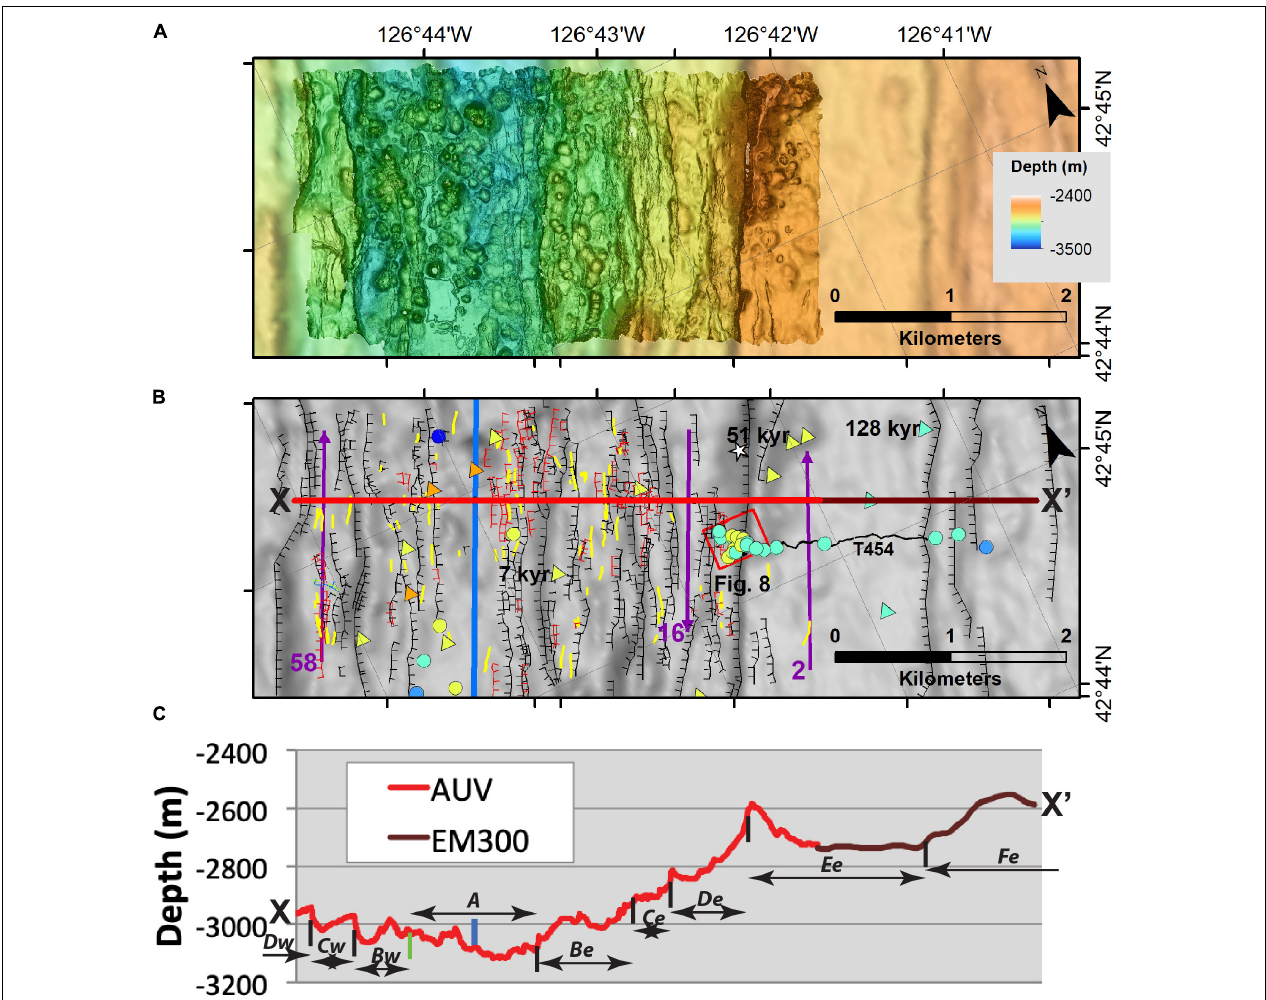
FIGURE 6 | (A) Maps and interpretations of a transect across the narrowest, shallowest part of the North Gorda segment east beyond the Sea Cliff hydrothermal vent field. All maps are rotated 23 ◦ clockwise and at the same scale. AUV bathymetry is shown on top of Simrad EM300 and EM302 bathymetry. (B) Locations of lava samples are indicated on faded bathymetry from map A, with symbols as in Figure 2 . Sea Cliff hydrothermal field is within the box outlining the location of Figure 8 and the newly discovered Apollo field is the white star. Line labeled X-X (cid:48) is the location of the cross section in panel C . Three NNE-SSW purple lines labeled 2, 16, and 58 are the locations of sub-bottom seismic profiles in Supplementary Figure S2 . Blue line is the estimated center of the axial graben (labeled A in panel C ), and used to measure distance that samples are located off-axis in Figure 7 . Linework shows inward-facing fault scarps in black, outward-facing fault scarps in red, fissures in yellow, and a pair of north- and south-facing scarps in green and blue. The numbers 7, 51, and 128 show the ages (in kyr) and locations of three lava samples dated by 238 U/ 230 Th disequilibria (Goldstein et al., 1991). Track of ROV Tiburon dive T454 is labeled. (C) Profile across the North Gorda segment, constructed from AUV survey data (red line) and Simrad EM300 ship data (brown line) to the east of the AUV survey, along the cross-section X to X (cid:48) in panel B . The profile has 2.5X vertical exaggeration and extends from ∼ 1 km west of the axis to 3 km east of the Sea Cliff hydrothermal site. Normal faults with 30–70 m vertical offsets are indicated by vertical black lines. Boundary between A and Bw (green vertical line) is where a major-offset fault should occur (to mirror the eastern blocks) but only a cluster of small offset faults are observed. The fault blocks labeled Dw, Cw, Bw, A, Be, Ce, De, Ee, and Fe from west (w) to east (e ) are